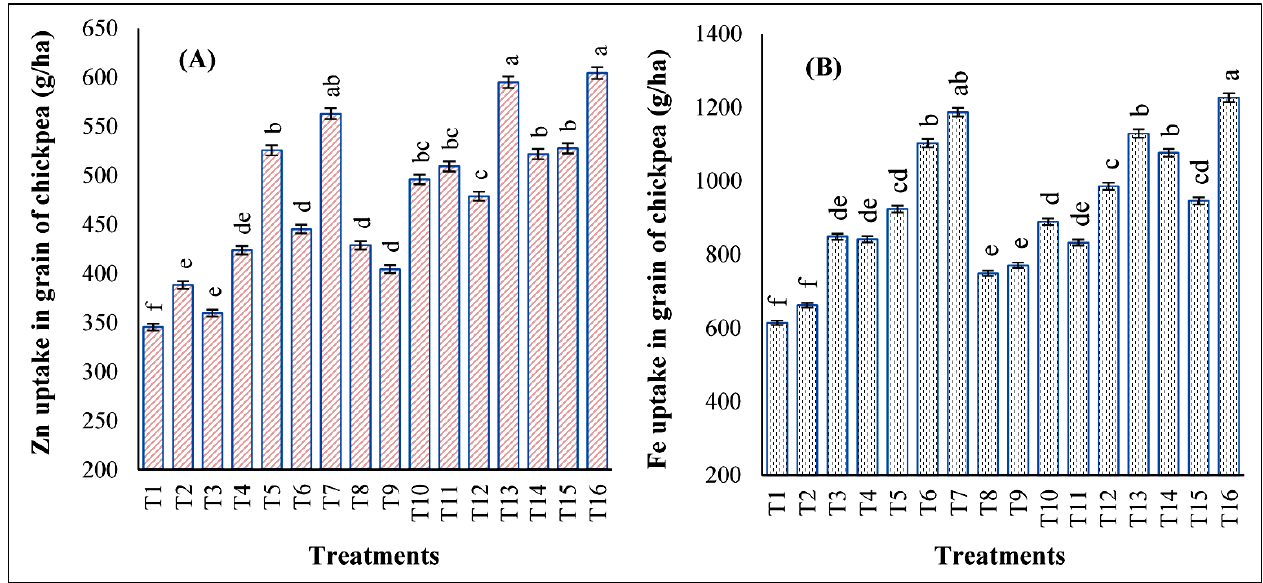
Figure 2. Effect of mineral, chelated and nanoforms of ( A ) Zn and ( B ) Fe on the uptake of Zn and Fe in grains of chickpeas. In each bar, means with a similar or dissimilar letter(s) were evaluated with the least significant difference (LSD) multiple range test, using a probability level of p ≤ 0.05.